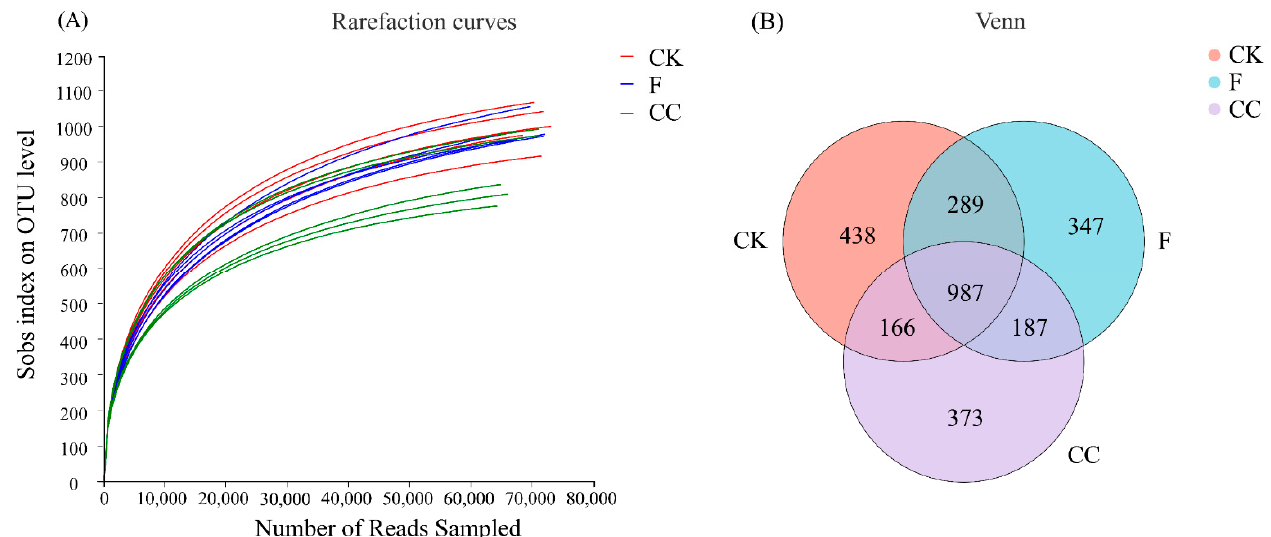
Figure 1. ( A ) Rarefaction curves of tea nursery soil samples and ( B ) Venn diagram of the control (CK), flooding (F) and calcium cyanamide (CC) treatments in tea nursery.